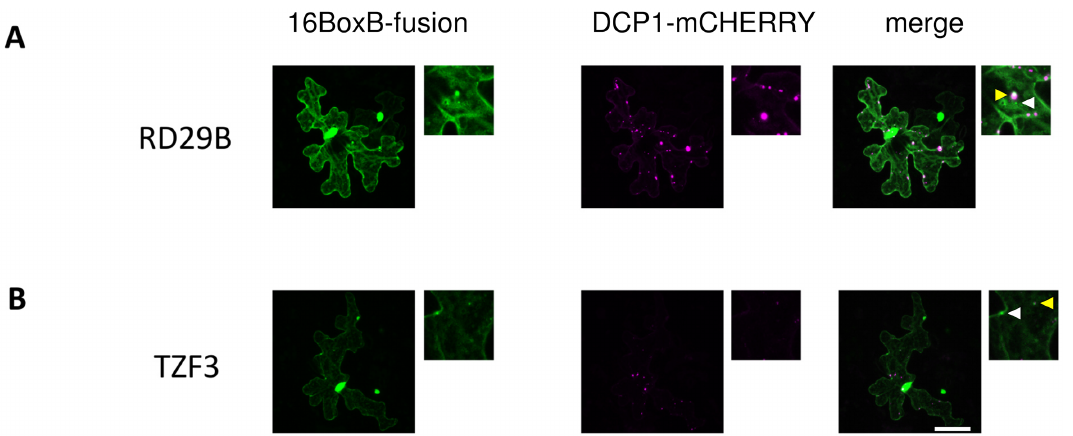
Fig 9. mRNAs of RD29B and TZF3 form cytoplasmic granules. 16BoxB-gRD29B (A) and 16BoxB-gTZF3 (B) are indirectly visualized by the LambdaN22-VENUS reporter in transiently transfected leaf epidermis cells (related to Tables 3 and 4). Column I presents the LambdaN22-mVENUS reporter, column II DCP1-mCHERRY, column III the overlay of column I (green) and II (magenta). Rectangular image magnifications present P-bodies nonoverlapping (white arrowheads) and P-bodies overlapping (yellow arrowheads) RNA accumulations. Scale bar: 25 μ m.